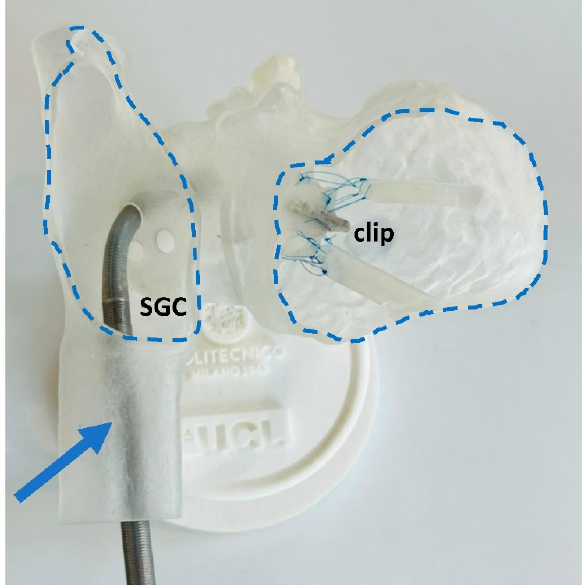
Figure 5. The steerable guide catheter (SGC) is visible in the printed model. The blue arrow identifies it within the IVC, while the dashed lines show the designed windows for visualisation from outside.